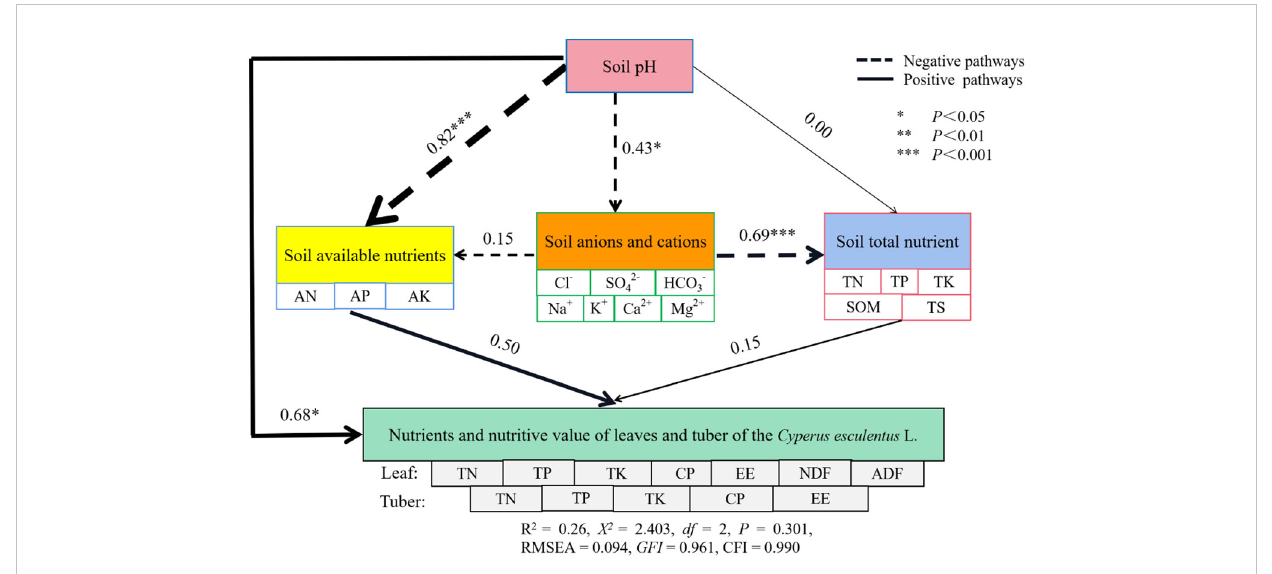
FIGURE 4 The structural equation model of effects of the continuous cropping (CC)/rotation cropping (RC) on nutrient content and forage nutritive value of leaves and tubers. Here: The principal component (soil available nutrients, soil anions and cations, soil total nutrients, and nutrient and forage nutritive value of the leaves and tubers) fi rst axis data are reported in Table